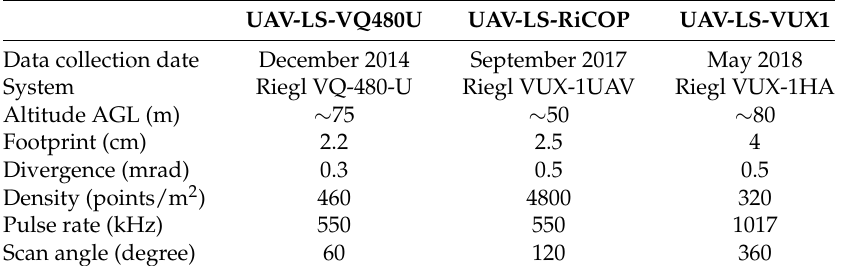
Table 4. Technical specifications of the above-canopy UAV laser scanning